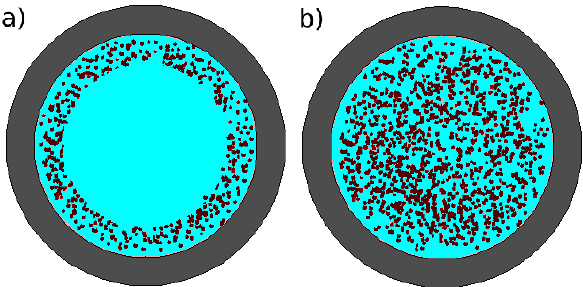
1.png Fig. 1 : A schematic representation of the two model patterns created for the validation of the tomography system. a) centered full ring pattern 1 cm thick; b) homogeneous particle distribu-